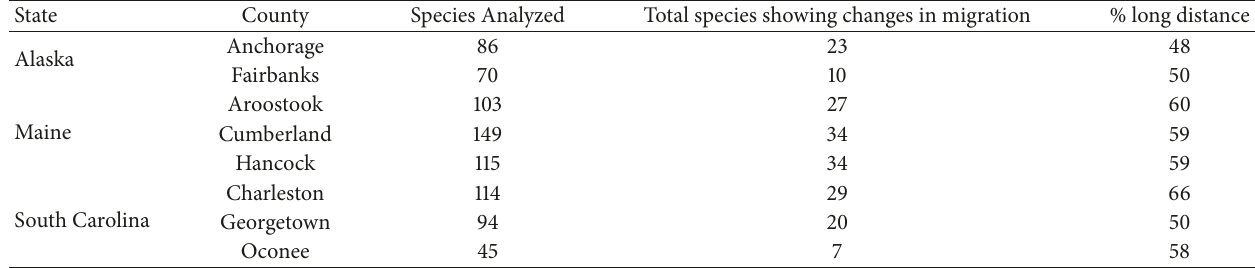
Table 2: Number of species analyzed, total number of species showing changes in migration pattern, and rate of species showing changes in migration pattern by county.